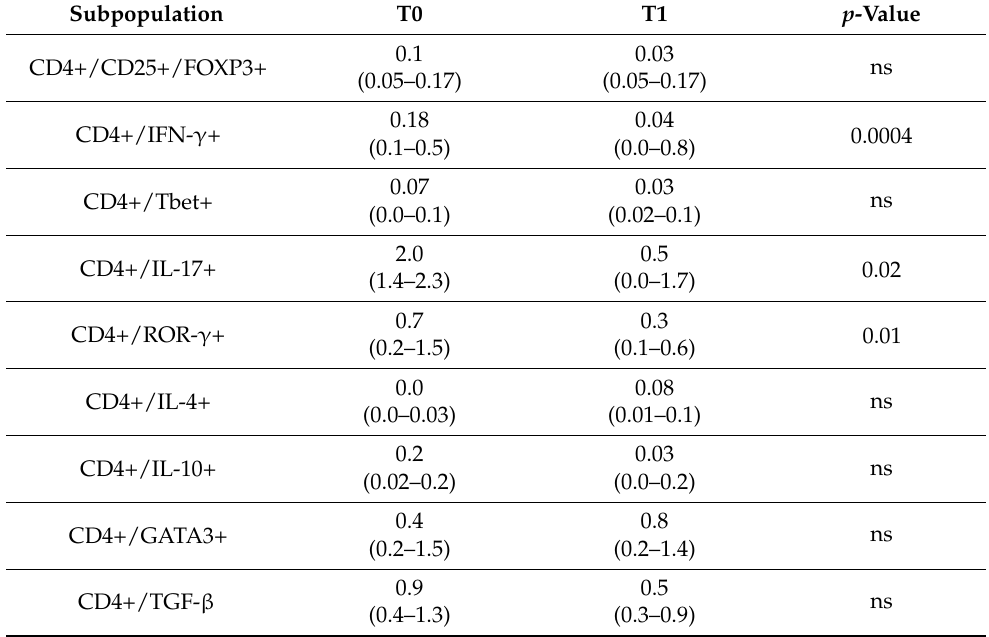
Table 3. Percentage of CD4+ T lymphocytes in patients with MS diagnosis before (T0) and after (T1) the B-HIPE program. Median, interquartile range, and statistical significance are shown. ns: not significant; Wilcoxon